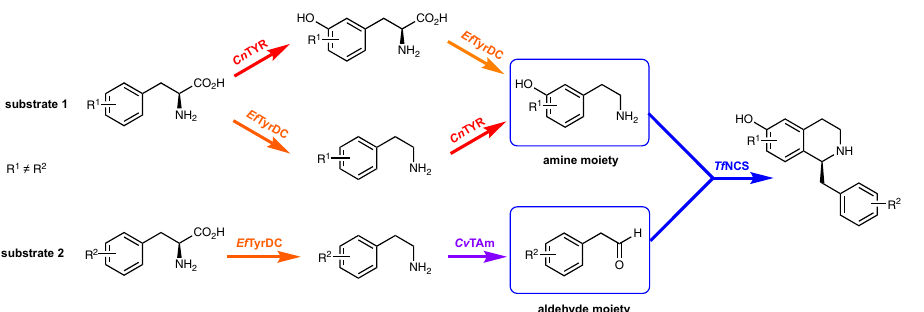
Fig. 3 | Parallel cascades with Cn TYR, Ef TyrDC, Cv TAm, and Tf NCS to non- naturalBIAs. Theaminemoietywasderivedfromanaminoacid(substrate1)using a Cn TYR- Ef TyrDC cascade. In a parallel pathway, another amino acid (substrate 2)